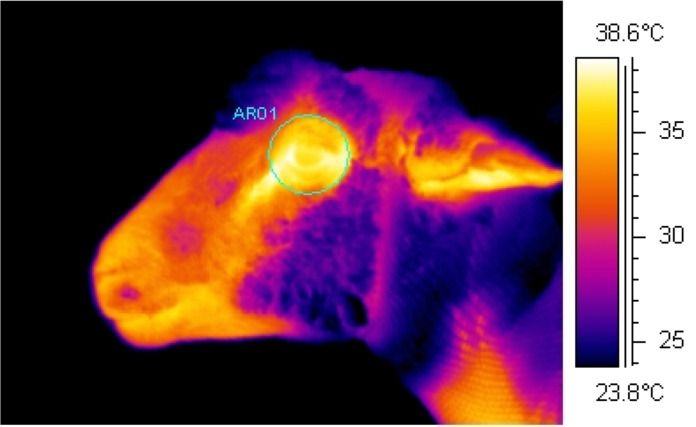
Example infrared image.Image shows the area traced around the eye region including the medial, posterior palpebral border of the lower eyelid and the lacrimal caruncle during analysis to determine the maximum eye temperature (°C).